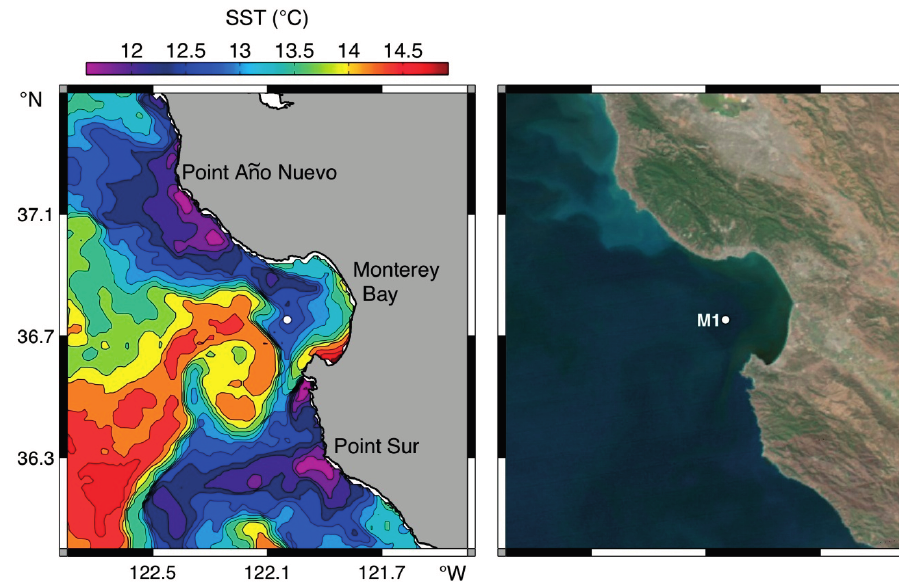
Figure 1. Overview of the study region. Thermal (AVHRR) and color (MODIS Aqua) images were acquired on 13 October 2008, at 11:04 and 14:20 local time, respectively, during a bloom of toxigenic diatoms